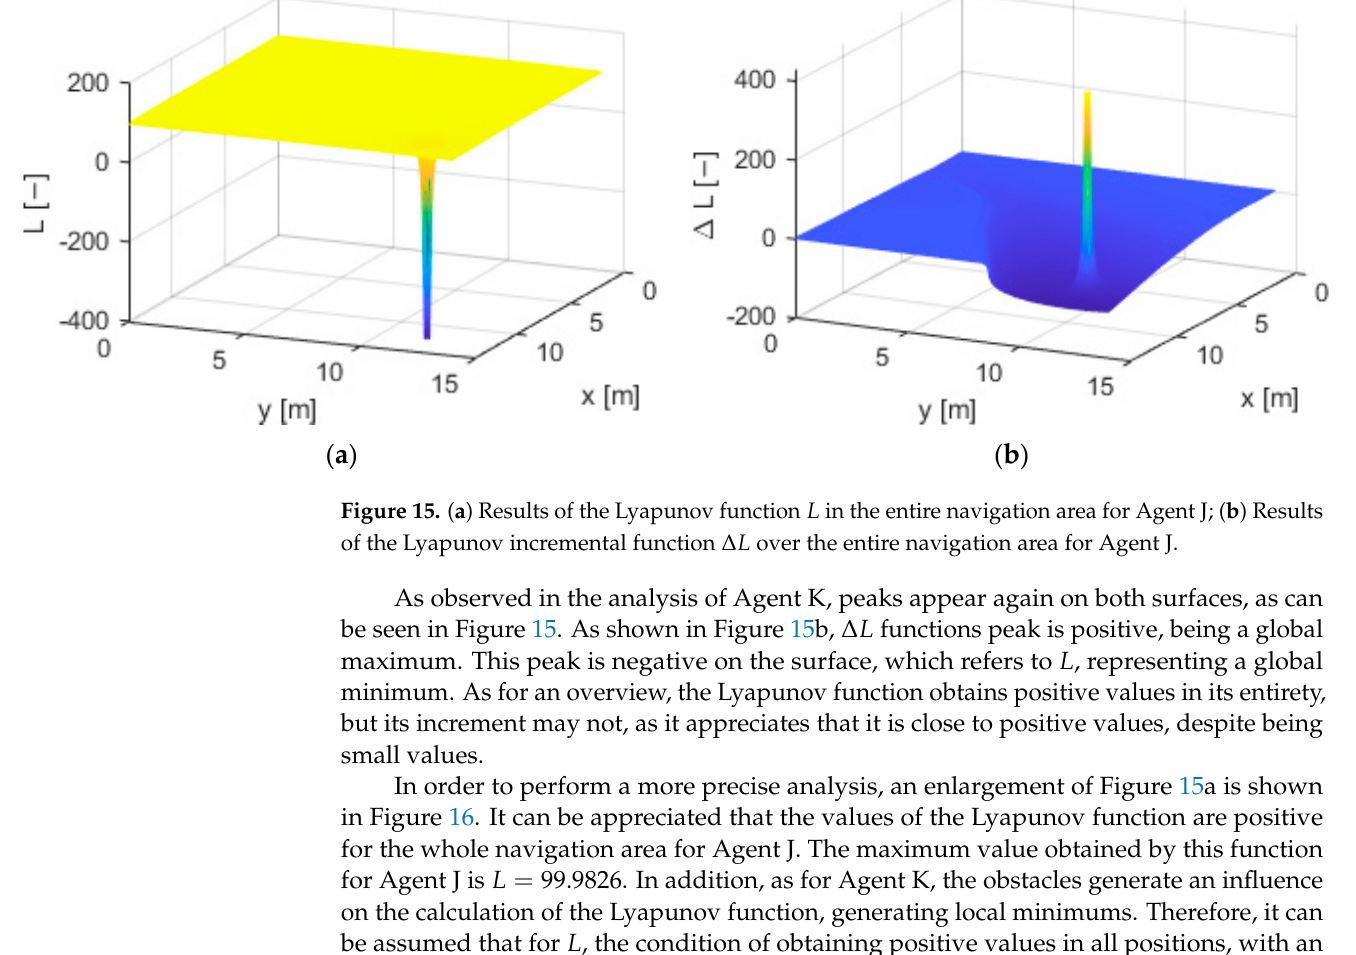
initial and final position.